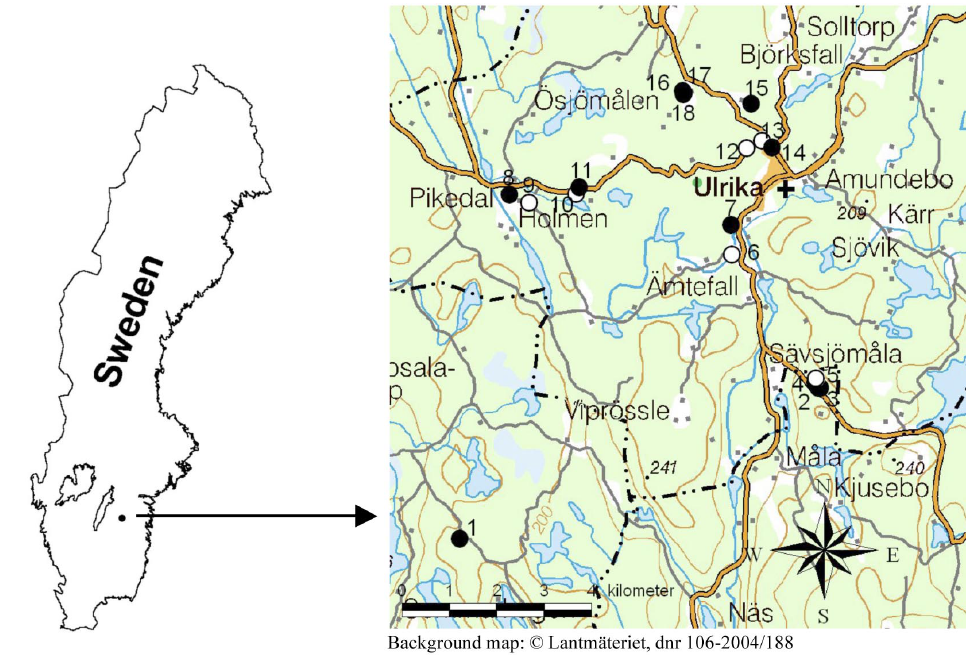
Fig. 1. The study area in southeast Sweden showing the relative positions of monitored ponds. Black circles indicate breeding ponds included in the model, while white circles indicate monitored ponds that were excluded from the model because reproduction of the great crested newt was not